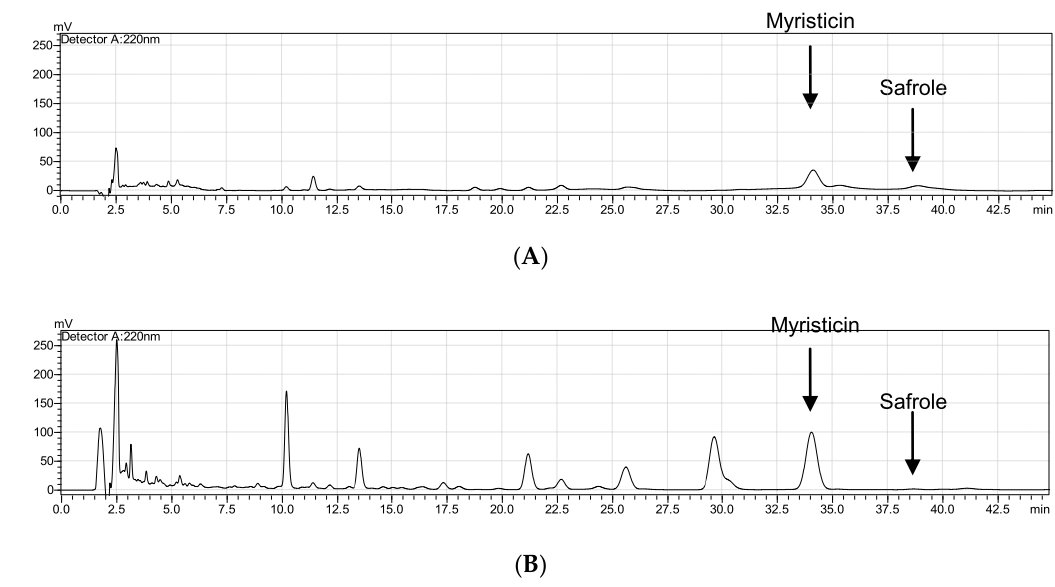
Figure 4. HPLC chromatograms displaying the components of MFO ( A ) and MFE-M ( B ).